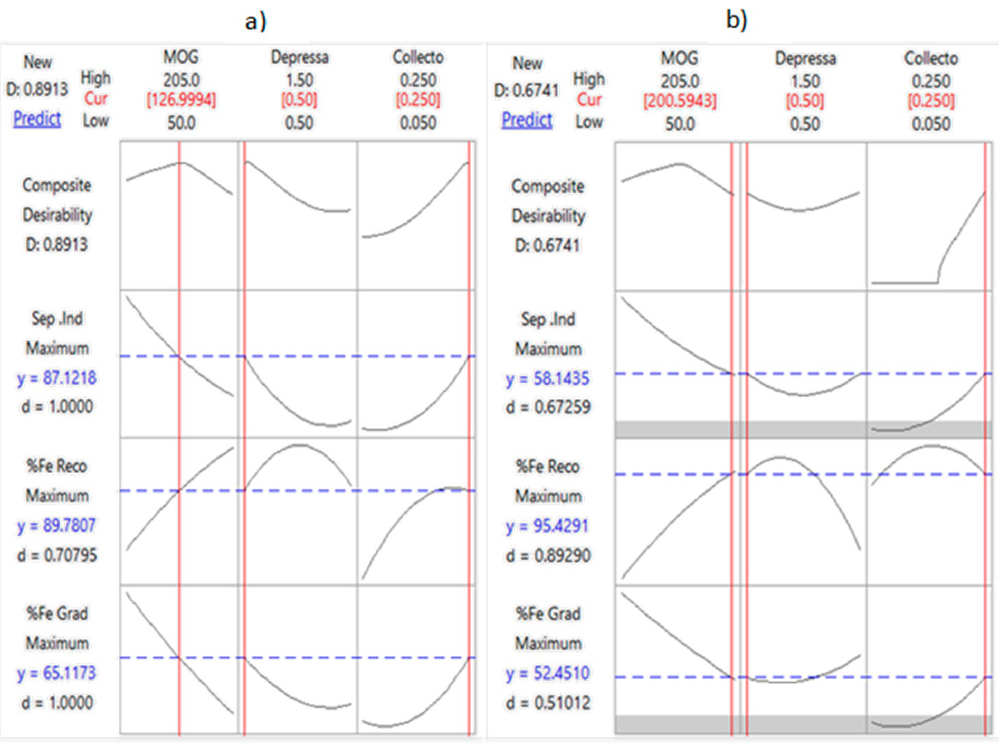
Figure 9. ( a ) Response optimizer plot for maximizing grade. ( b ) Response optimizer plot for maximizing recovery. Table 5. Results of the final WHIMS test followed by flotation of the WHIMS concentrate.